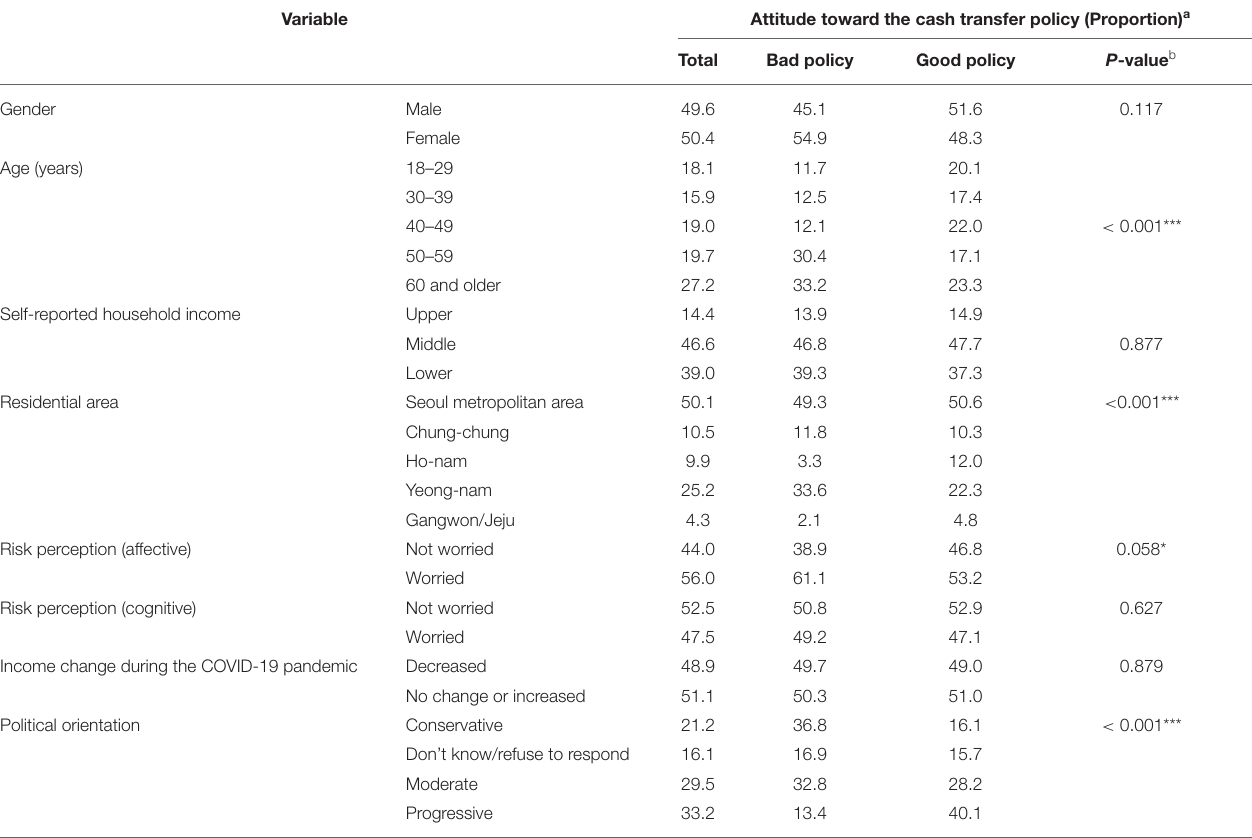
TABLE 1 | Participants’ basic